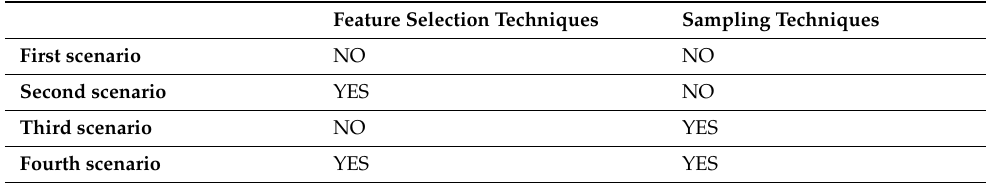
Table 2. Scenarios in the empirical